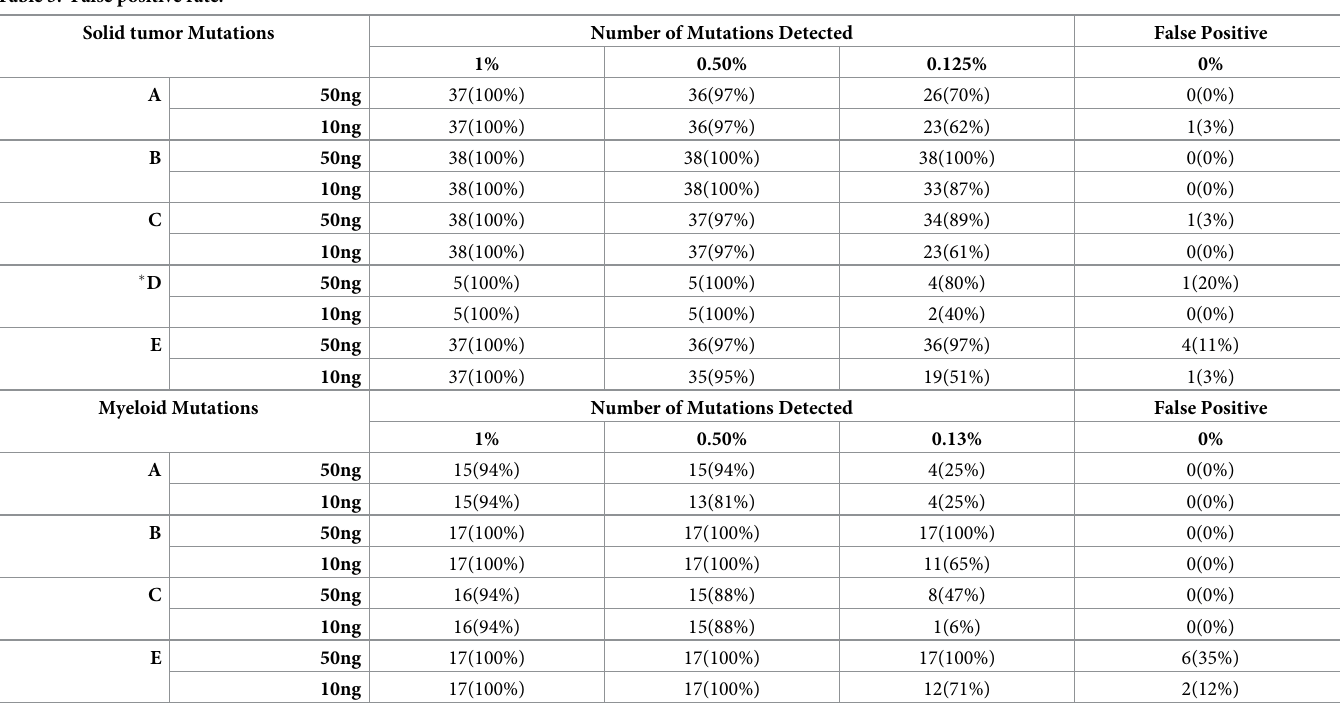
Table 3. False positive